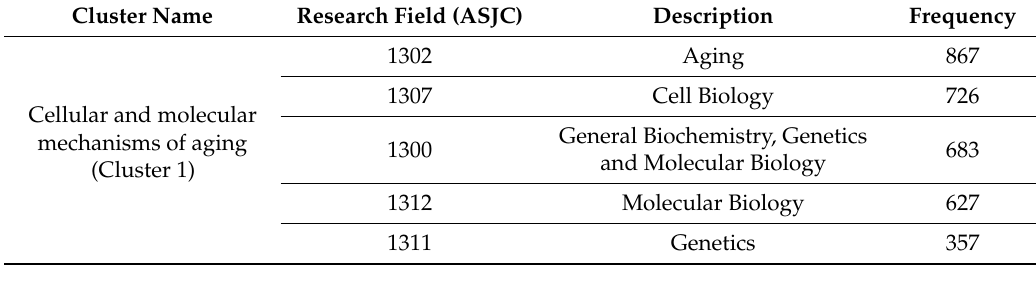
Table 2. Major research fields in Cellular and molecular mechanisms of aging (Cluster 1).